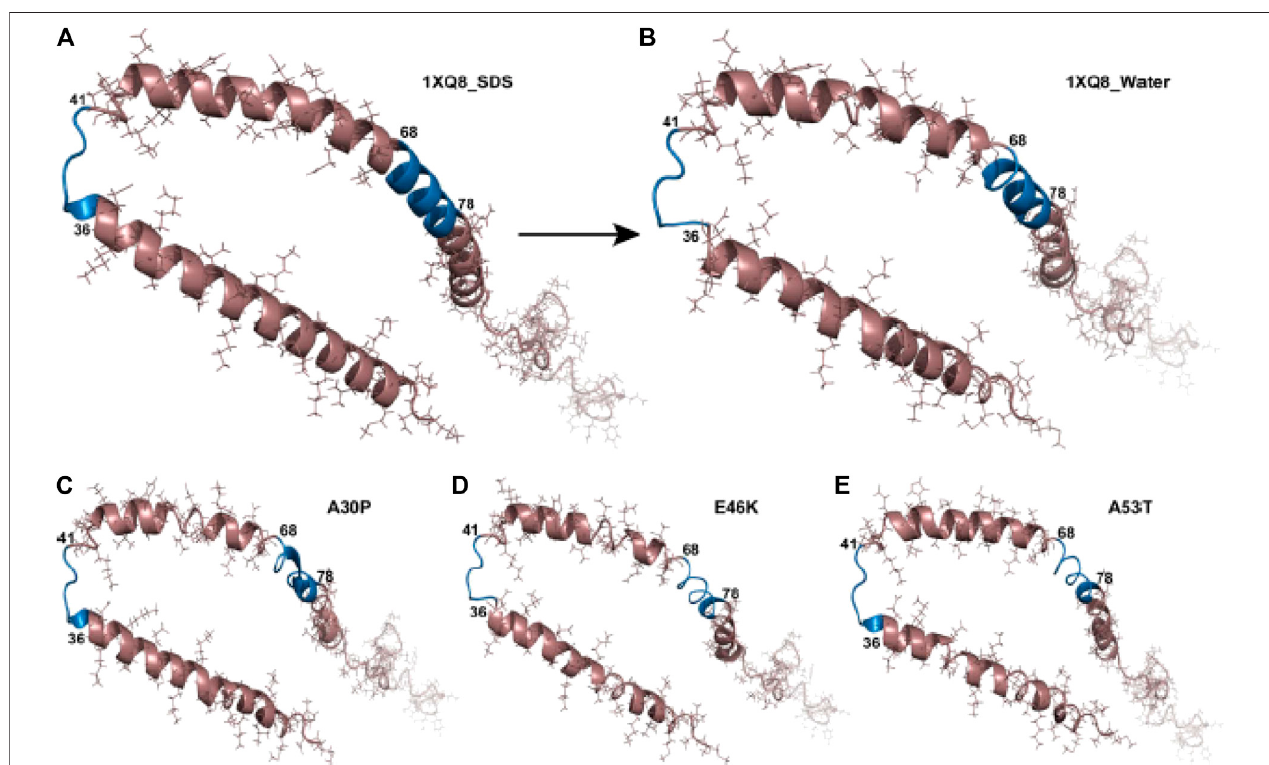
FIGURE 5 | Structural changes in α Syn and the hydrophobic regions. Structure of (A) wild type (1XQ8) in SDS solvent, (B) wild type (1XQ8) simulated in explicit water conditions, (C) A30P mutant in water solvent, (D) E46K mutant in water solvent, (E) A53T mutant in water solvent. The blue region depicts the 36 – 41 and 68 – 78 hydrophobic regions in α Syn showing aggregation propensity (Kumar et al.,